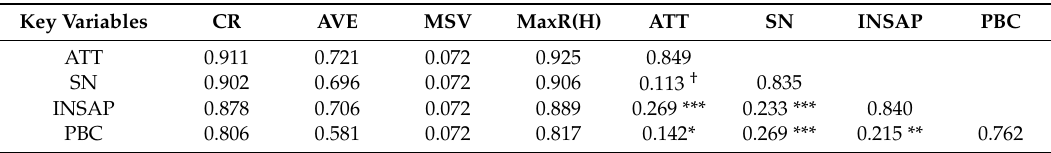
Table 4. Reliability and Validity Test.